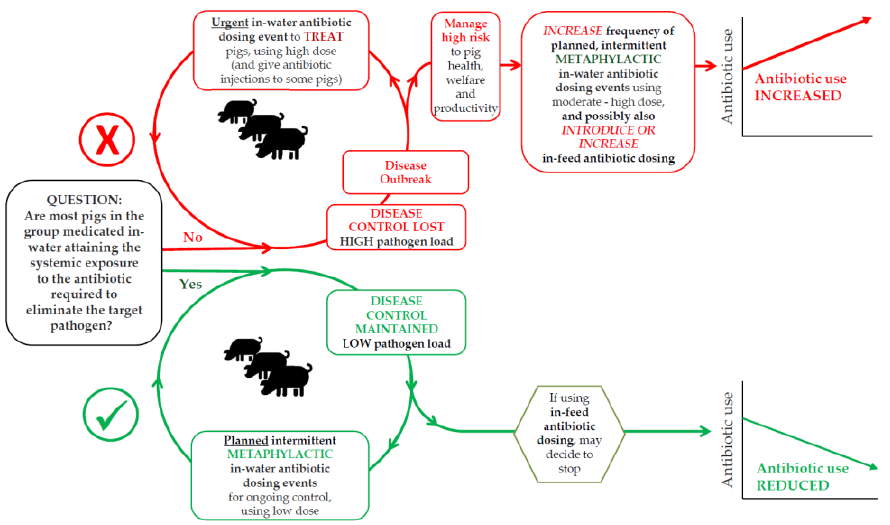
Figure 4. Schematic showing possible pathways resulting in increased antibiotic use (red) or reduced antibiotic use (green) in pigs, based on whether most pigs in the medicated group have sufficient systemic exposure to the antibiotic to eliminate the target pathogen.